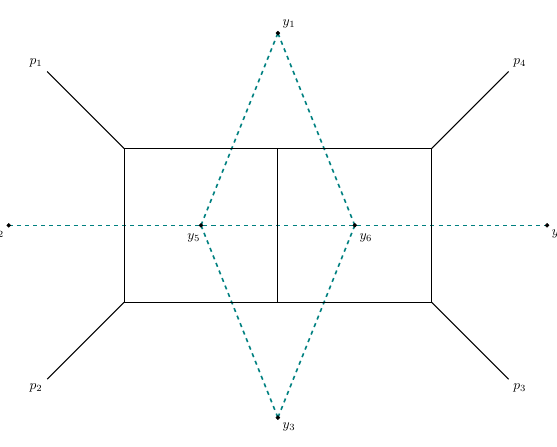
Figure 2 . The two loop box digram with its dual. This diagram is not conformal in coordinate and dual coordinate space at the same